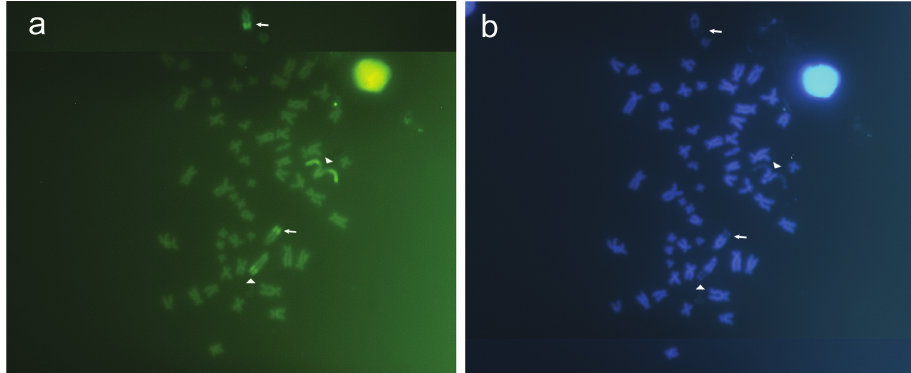
Figure 5. Metaphases of Farlowella amazonum stained with ( a ) Chromomycin A indicate pair 28 and arrows head indicate pair 27